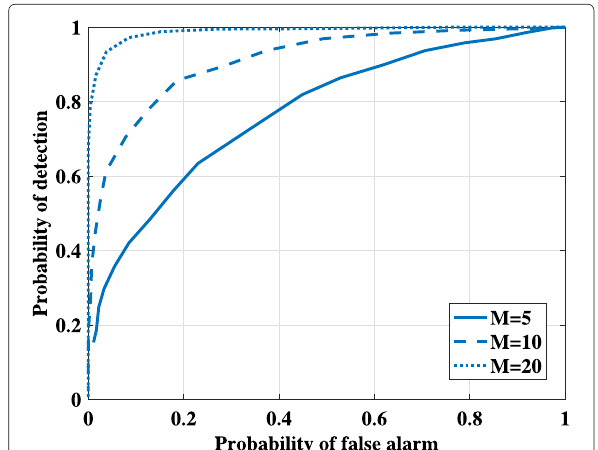
Fig. 8 Probability of detection versus probability of false alarm for N = 5 and I = 3 and b sp 0 = 10 3 ×